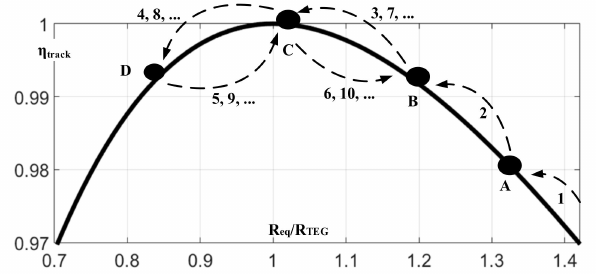
Figure 5. Process of the time exponential rate P&O